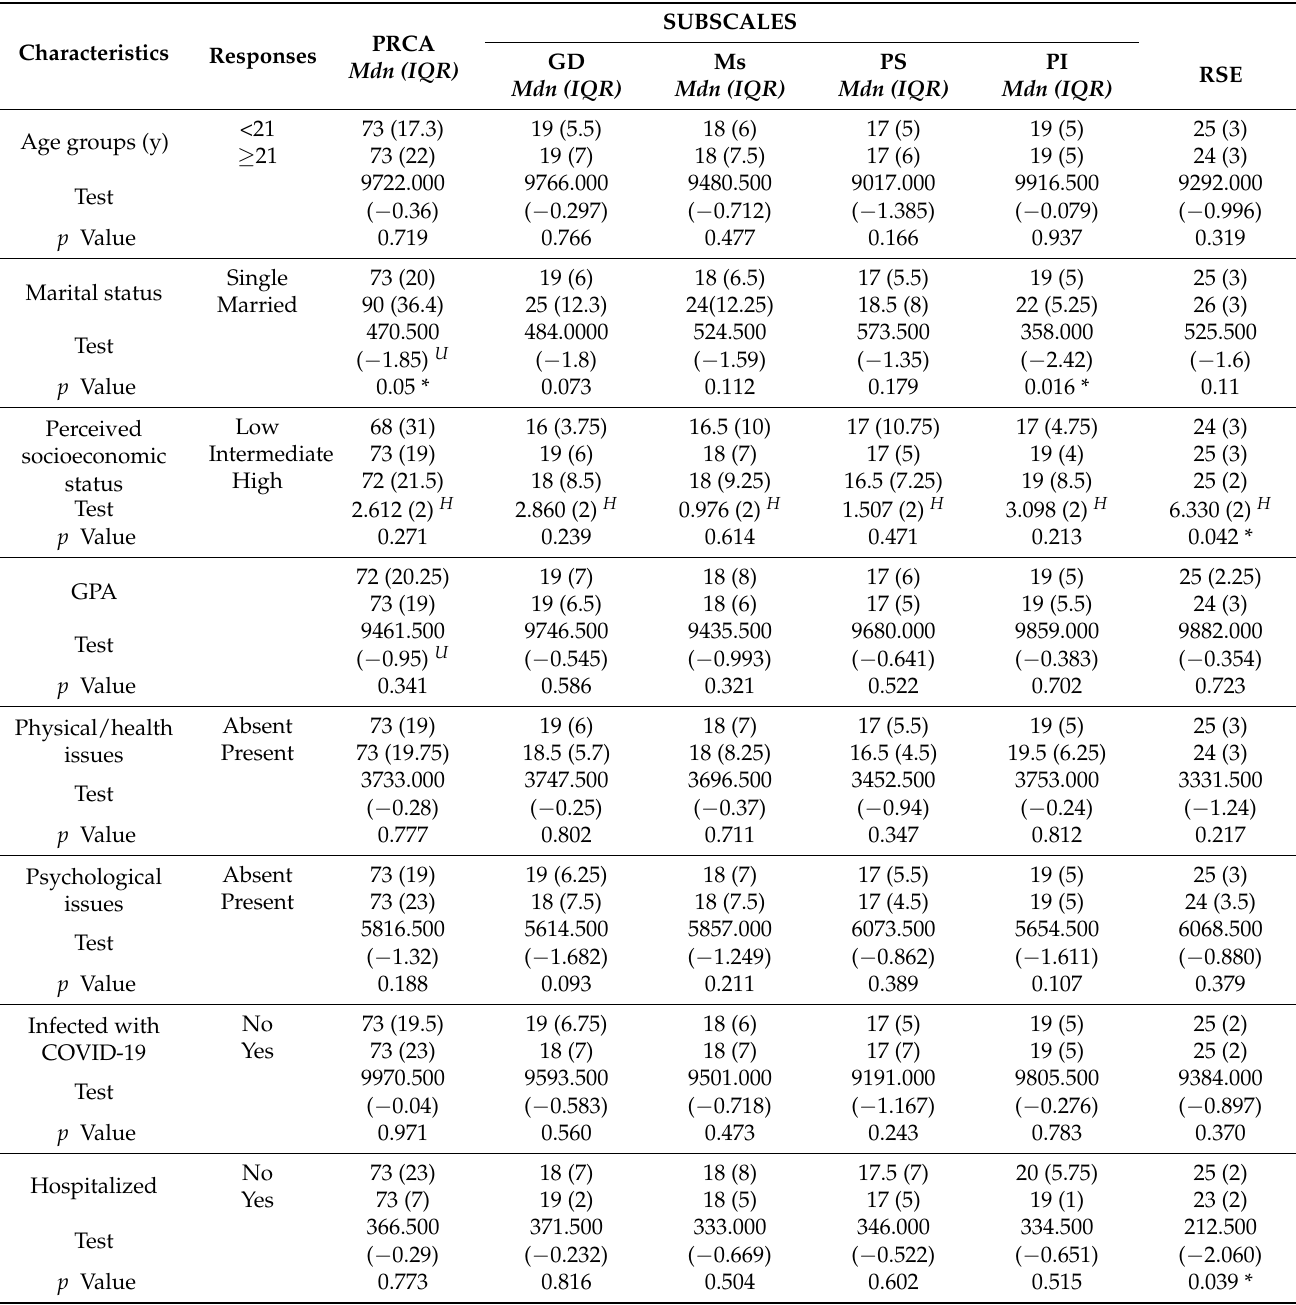
Table 3. Comparing personal characteristics of respondents with PRCA and RSE (N =